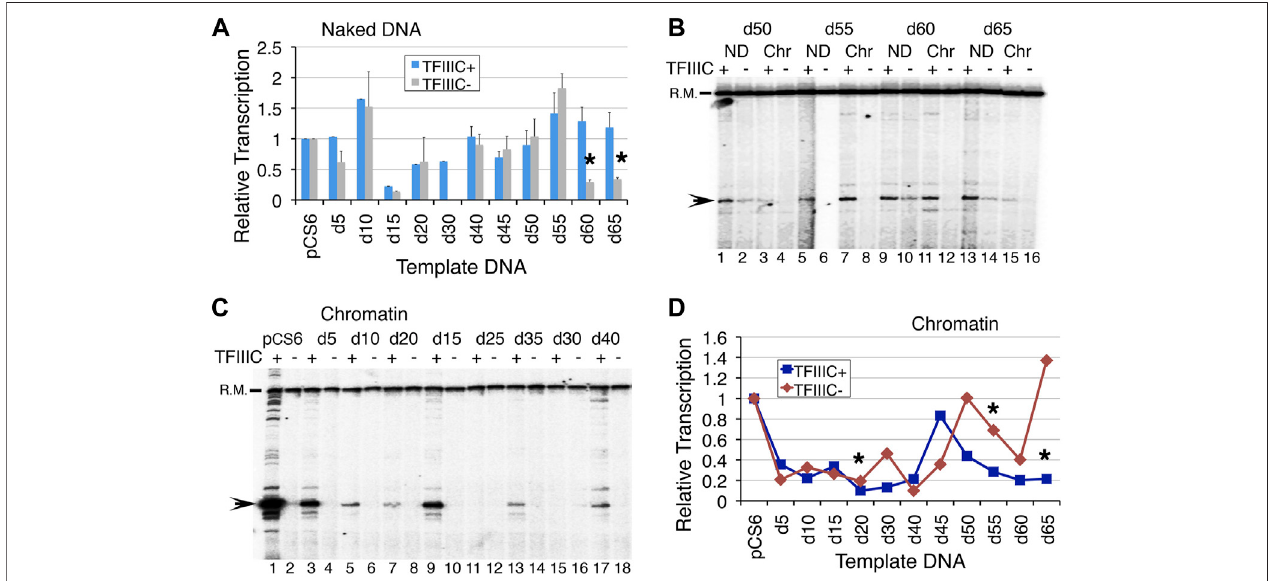
FIGURE 2 | Reducing the distance between boxes A and B in 5 bp increments affects SNR6 transcription. Plasmids as naked DNA or assembled into chromatin were used as templates for in vitro transcription assays with or without the addition of pure TFIIIC. A radiolabeled probe of a non-U6 sequence externally added before transcriptextractionwasusedastherecoverymarker(R.M.)andnormalizer.PositionsofR.M.andU6transcriptaremarkedontheleft-handsideofthegelimages.Gels were scanned in a PhosphorImager machine and the Image Guage (Fuji) software was used for quanti fi cations of the transcripts. (A) Average and scatter of the measured U6 transcripts from three independent experiments. All levels were normalized against the respective pCS6 transcription levels in the absence/presence of TFIIIC.Asterisksmarkthesigni fi cantdifferencesbetweentheTFIIIC-andTFIIIC+transcriptionford60( p =0.0016)andd65( p =0.0178). (B) Comparisonoftranscription from chromatin (Chr) and naked DNA (ND) in the presence/absence of TFIIIC. ND shows transcripts from all but the chromatin is not equally repressed in each case. (C) Comparison of the transcription from chromatinized deletion clones in the presence and absence of TFIIIC. (D) Comparison of quanti fi cations of chromatin transcription shows different expressions from all the deletion clones. All measurements were normalized against the respective pCS6 levels. Asterisks mark the signi fi cant changes for d20 ( p = 0.014), d55 ( p = 0.023), and d65 ( p =